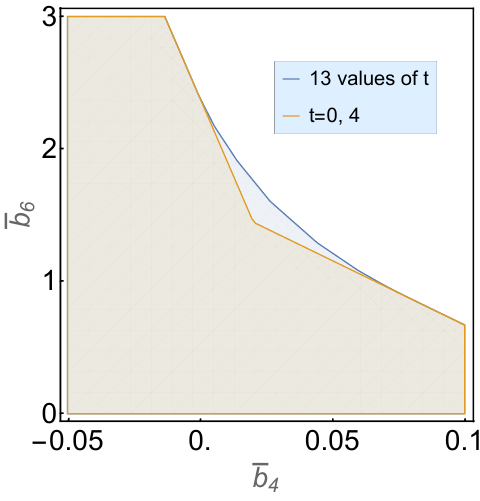
Figure 2 . The positivity constraints on the parameter space of f b 4 ; b 6 g with other b i set to the central values of the (cid:12)t (4.12). The yellow region is ruled out by the Y bounds with (cid:17) = 0 ; t = 0 ; 4, and is smaller than the blue region that is ruled out by the Y bounds with (cid:17) = 0 and 13 values of t